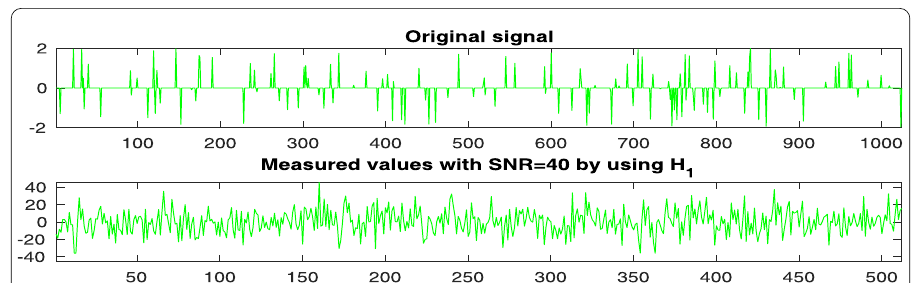
¯ ξ k are the same = 0.75 k